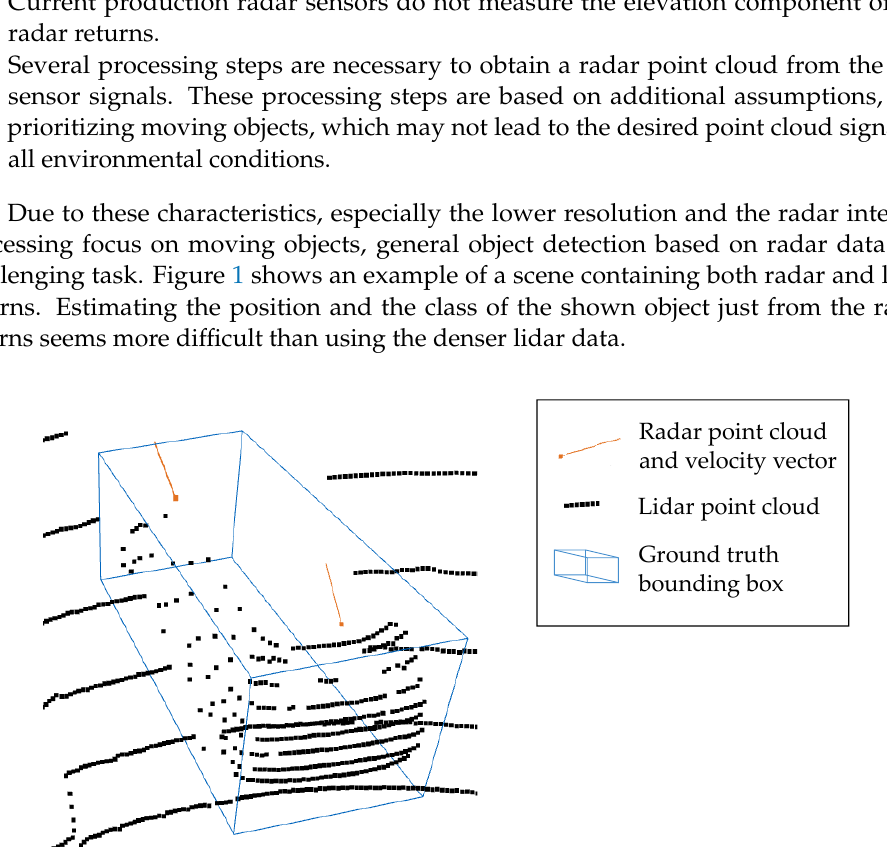
Figure 1. A vehicle detected by both radar and lidar sensors. The radar point cloud density is lower than the lidar point cloud density. Taken from nuScenes sample with the unique identifier token: